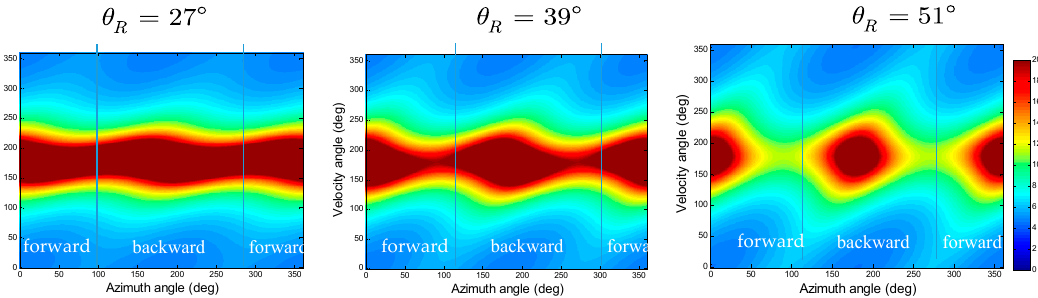
Figure 6. The azimuth resolution with respect to velocity angle β and received azimuth angle ϕ R when θ T = 29.55 ◦ .